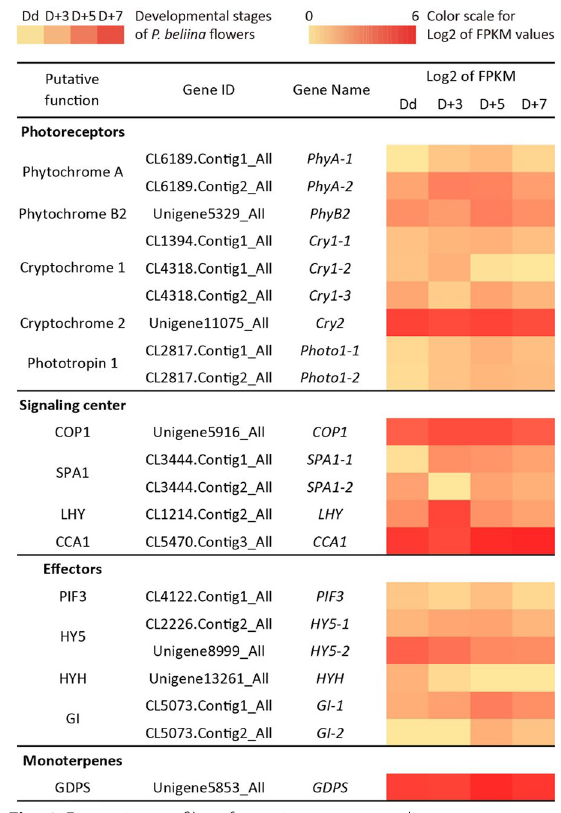
Fig. 6 Expression profiles of putative genes encoding components involved in light and circadian clock signaling pathway in P. bellina floral transcriptomes. The gene expression levels are represented by a color gradient from red to